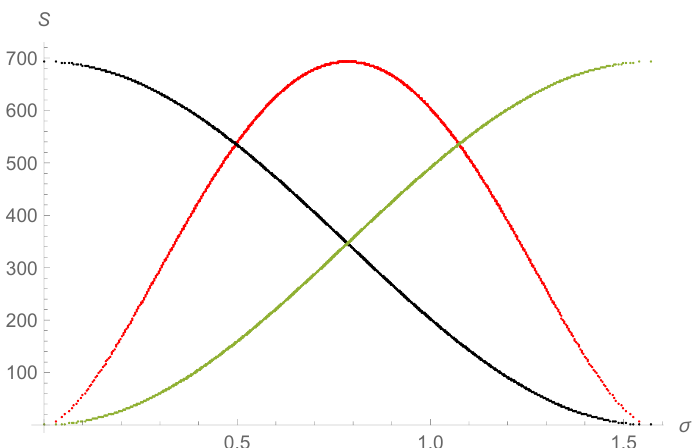
Figure 5. Plot of S BH (black), S env (green) and S I (red), as function of σ , for N = 1000. Figure taken from